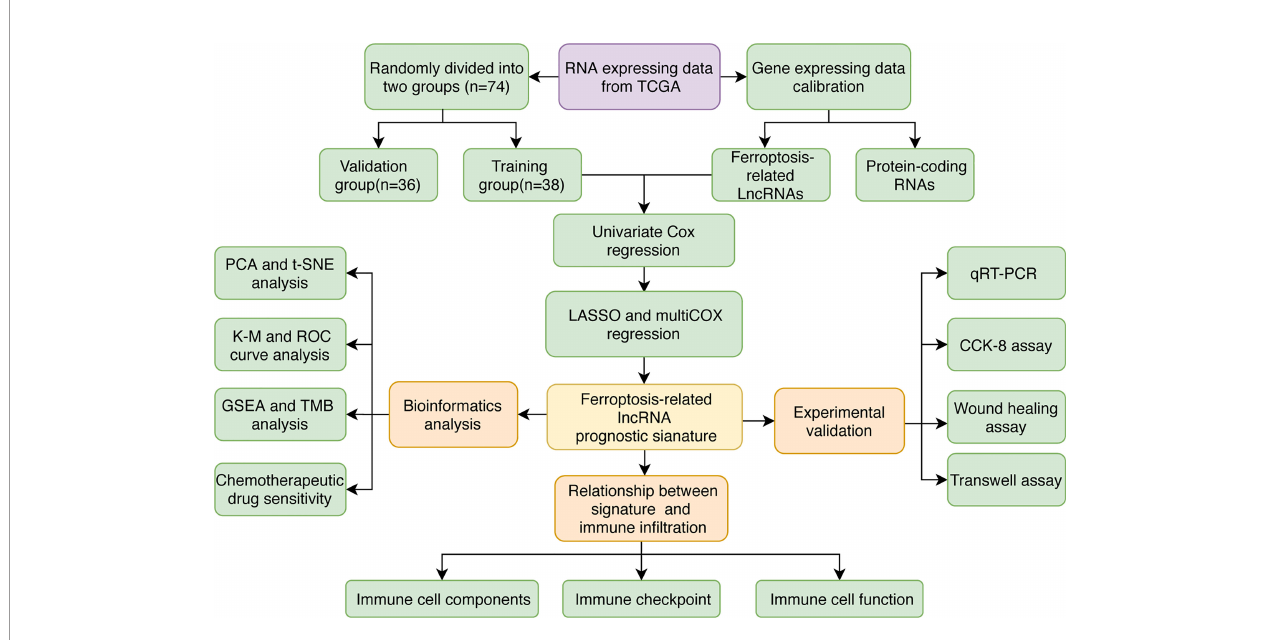
FIGURE 1 | The study fl